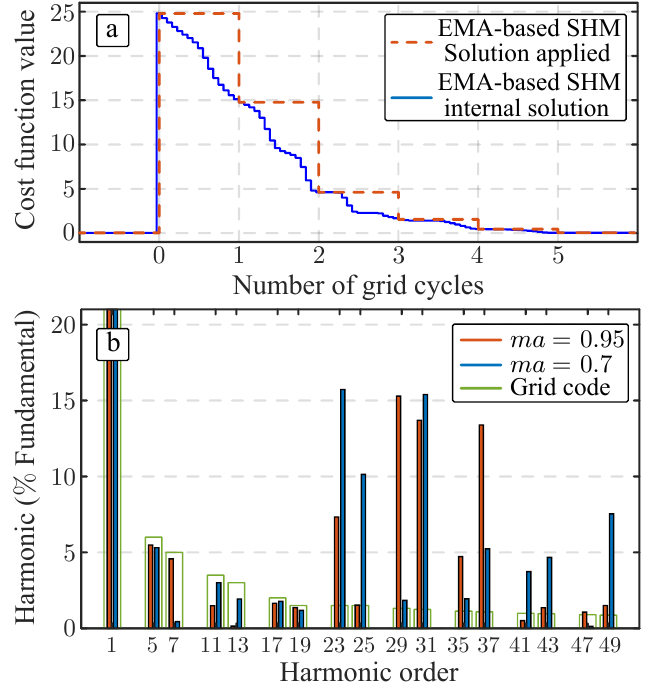
Figure 10. Transient response of the EMA-based SHM strategy when a modulation index step is applied from m a = 0.95 to m a = 0.7. ( a ) Evolution of the cost function value each fundamental period. ( b ) Steady-state output voltage harmonic spectra with both modulation indexes and applied grid code